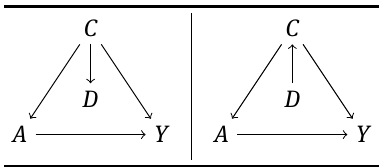
Figure 1: Causal graphs, where Y is a discrete or continuous random variable, and A , C and D are binary random variables. Moreover, C is